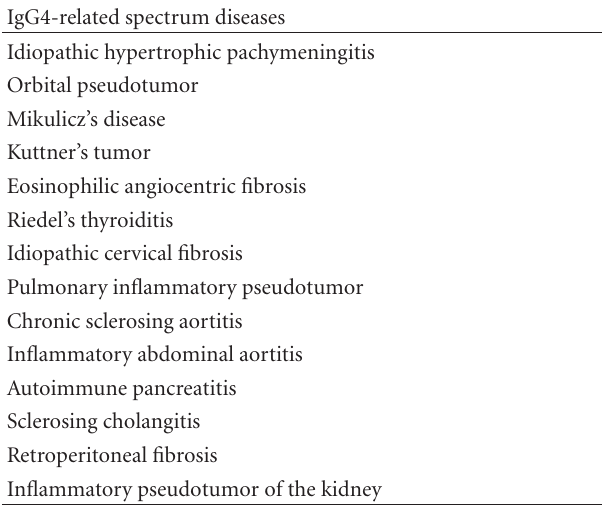
Table 1: Diseases commonly associated with IgG4-related